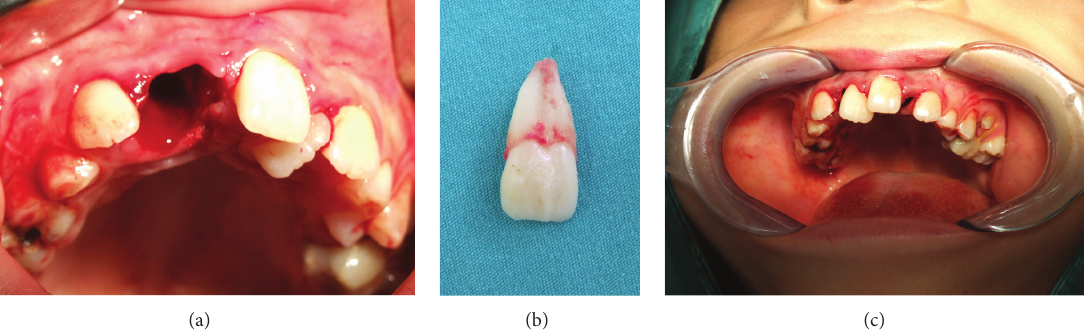
Figure 3: (a) View of the extraction socket of the large incisor; (b) the extracted incisor, demonstrating large crown and root dimensions and morphological appearance of a fused tooth; (c) view of the supernumerary incisor, immediately after implantation into the recipient site.